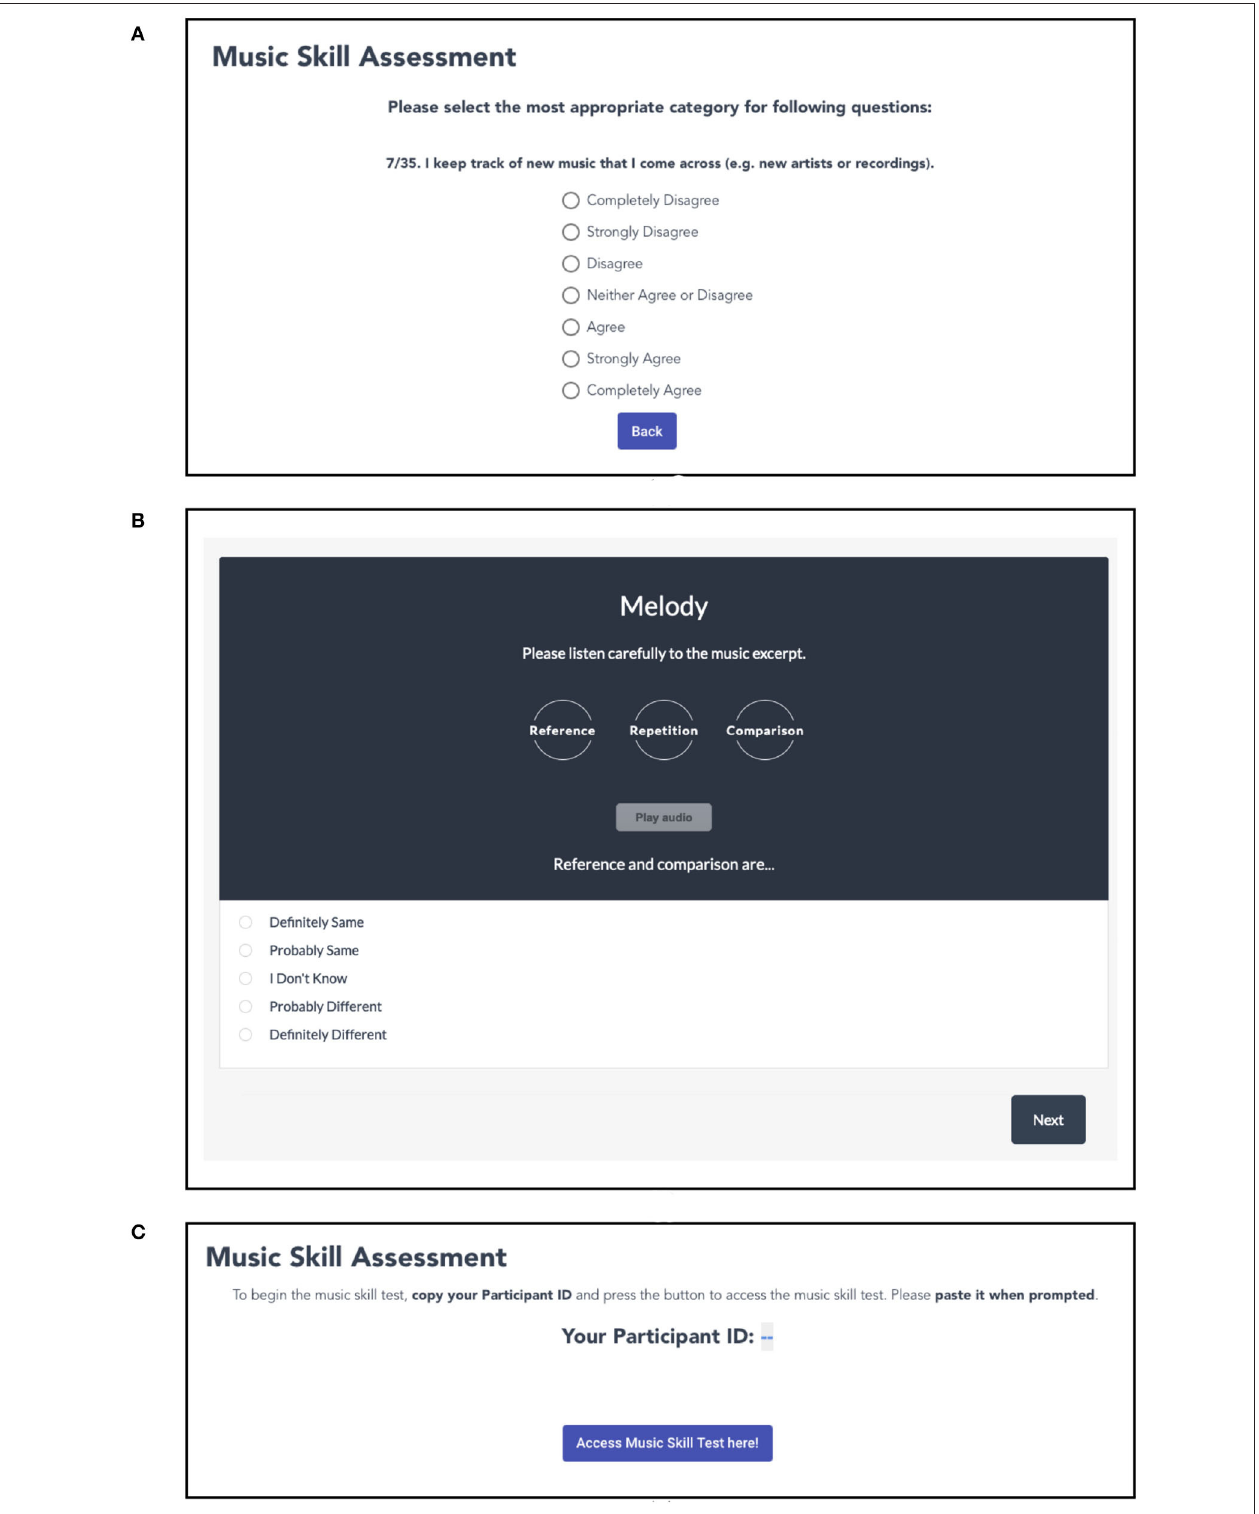
FIGURE 2 | Interfaces of the study ( A , GMSI questionnaire, B , Mini-PROMS, and C , Participant ID prompt).